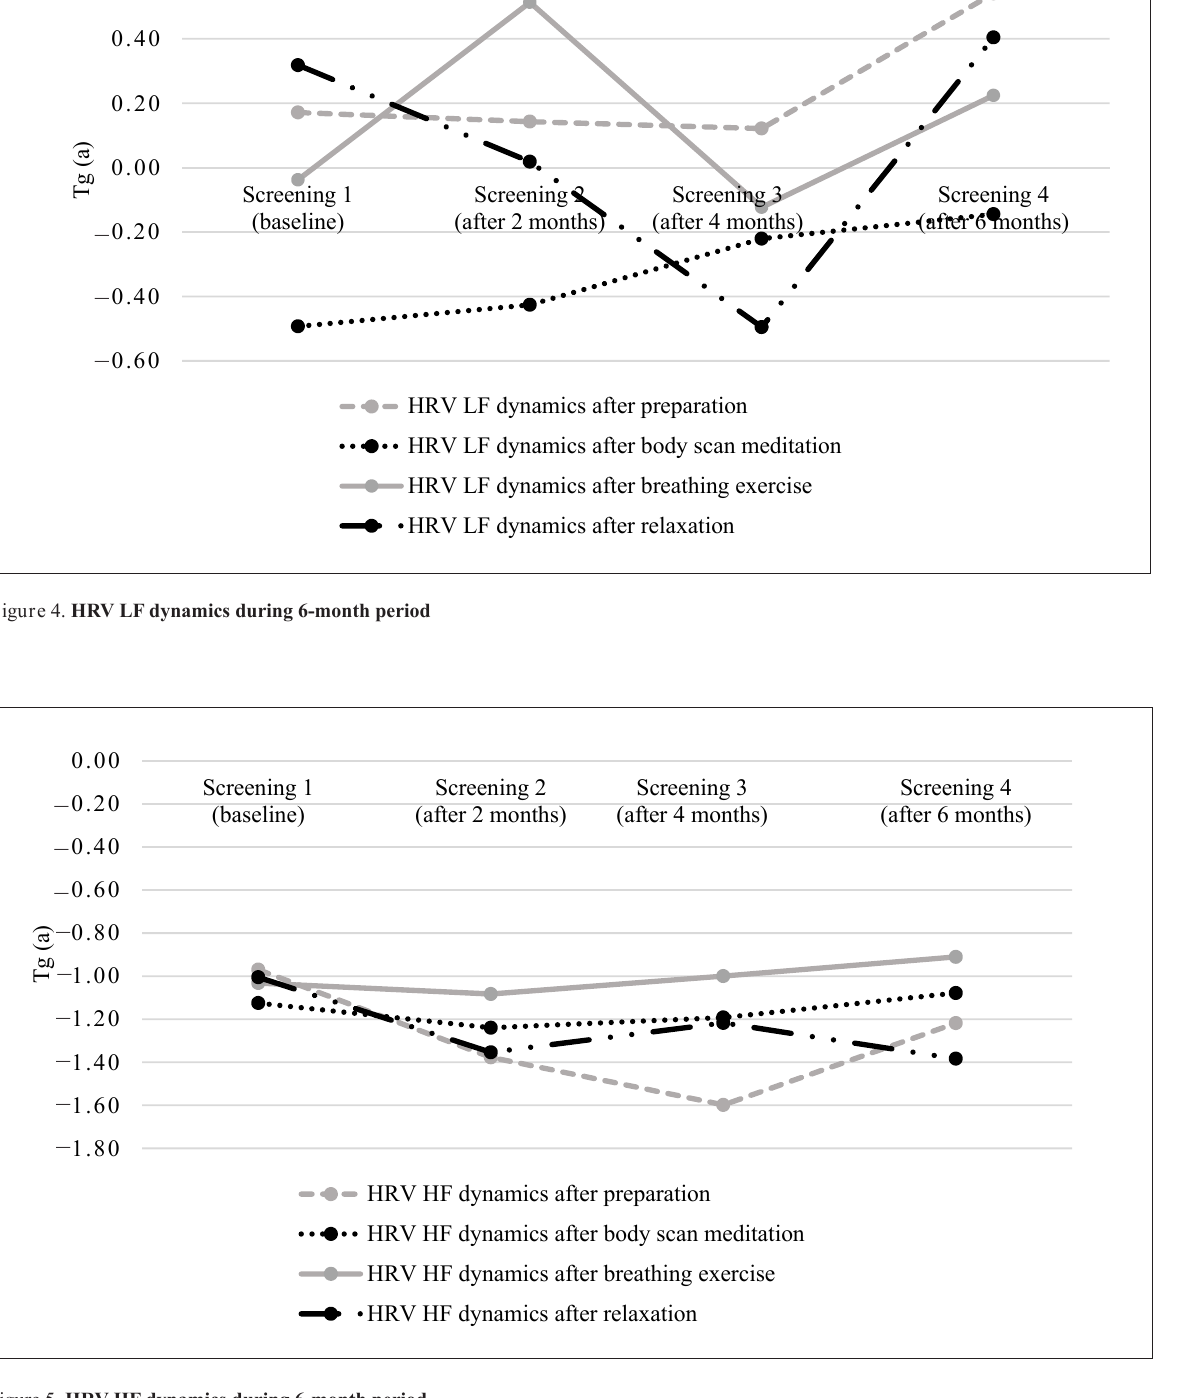
Figure 5. HRV HF dynamics during 6-month